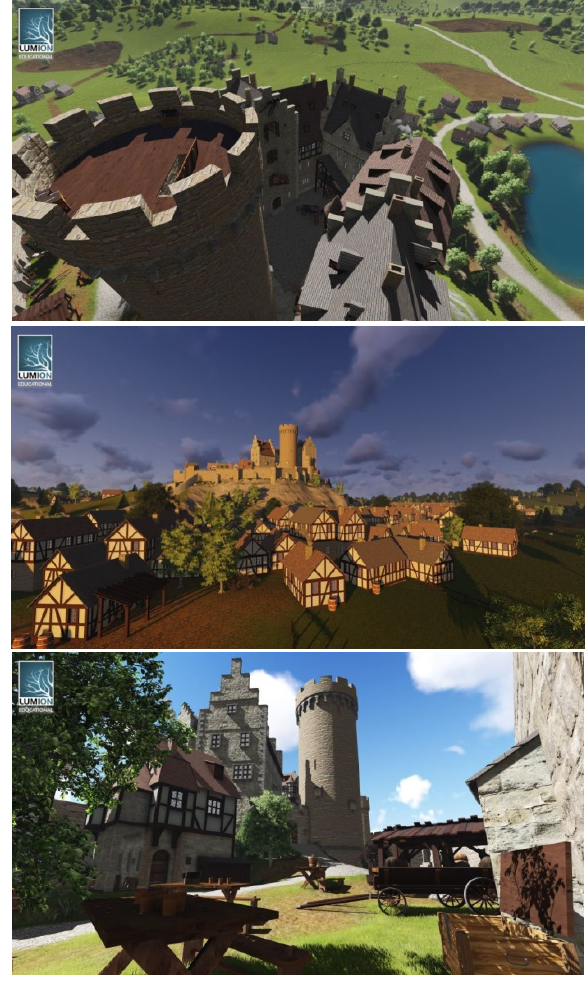
Figure 12. View from the castle keep (top), from the north (middle) and from the castle yard (bottom) generated with